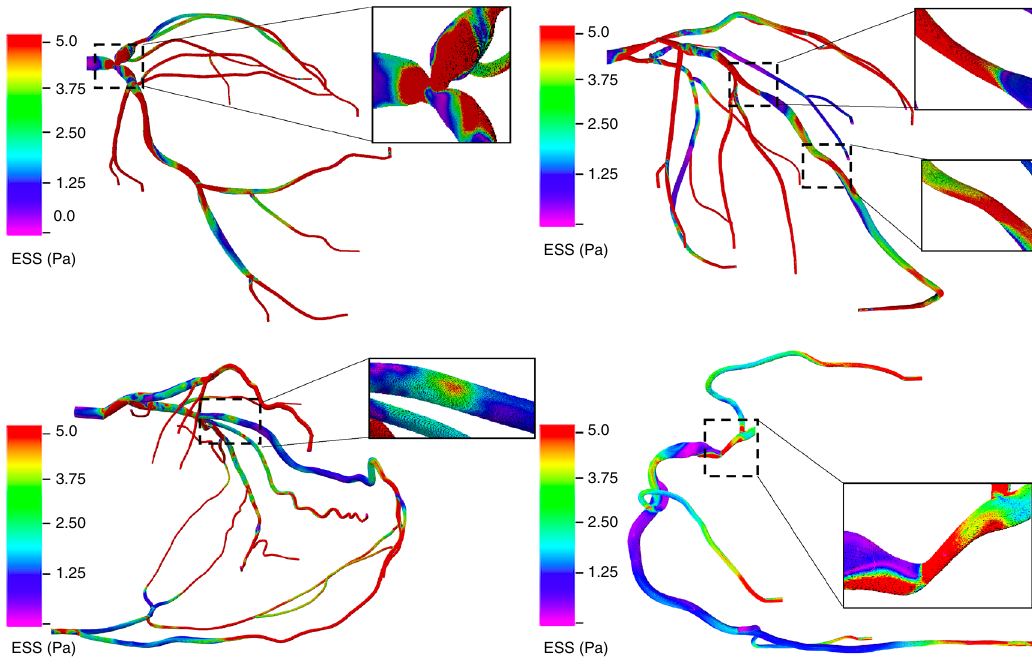
Figure 4. Endothelial shear stress in arterial geometries with different complex coronary lesions: (top left) bifurcation lesion (top right) serial lesion (bottom left) RCA vascular bed via collaterals (bottom right) ostial lesions. The inset marks the region of the stenosis.